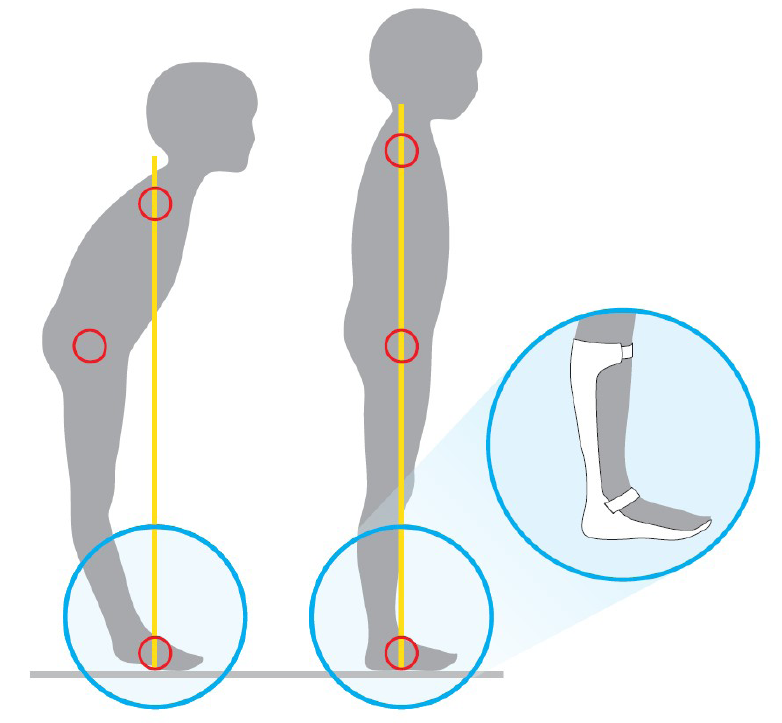
Figure 1. Children with CLN2 disease who developed equinus contractures, typically compensated for this foot deformity by hyperextension of the knees, backward displacement of the pelvis, forward displacement of the trunk and hyperextension of the neck. As a result, their ability to stand and walk became severely restricted and independent standing and walking rapidly became impossible. The equinus position can be corrected with the help of orthoses. As a result, the child can assume a more favourable upright position, which greatly supports standing and walking. Positive effects may also be observed on communication, independence and contracture